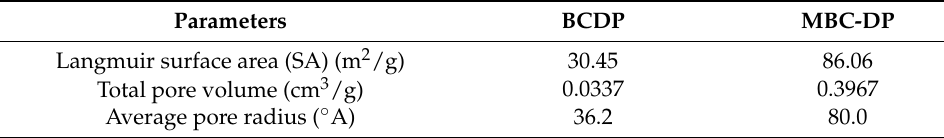
Table 3. Brunauer–Emmett–Teller (BET) analysis of BCDP and